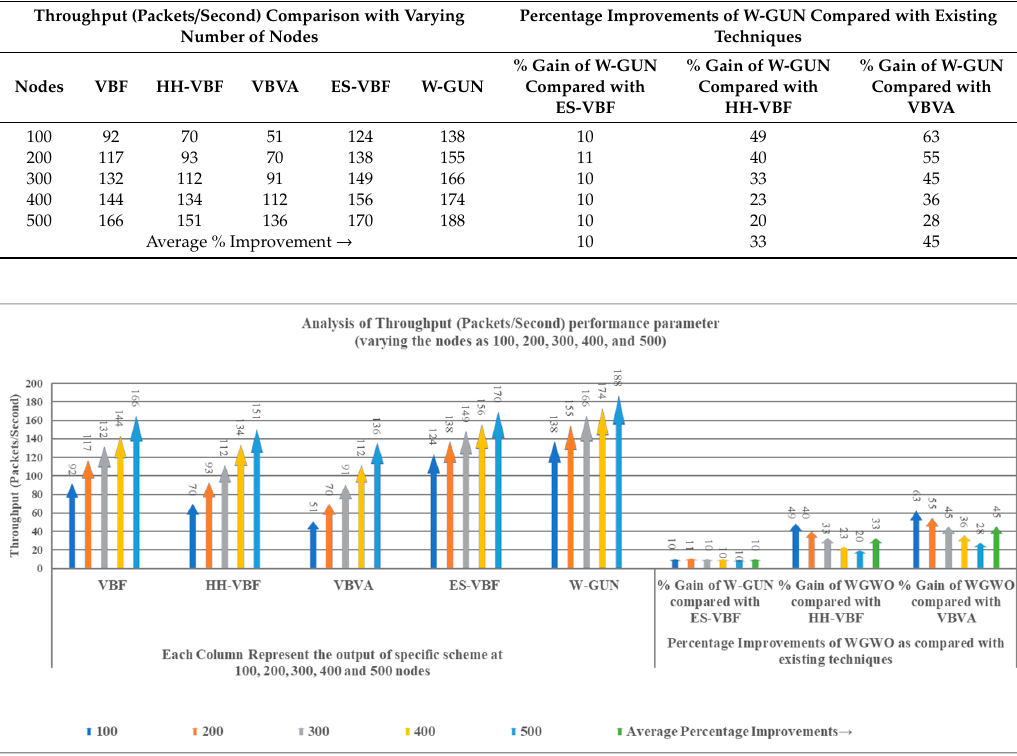
Figure 12. Detailed percentage-centric performance gain of W-GUN focusing throughput.